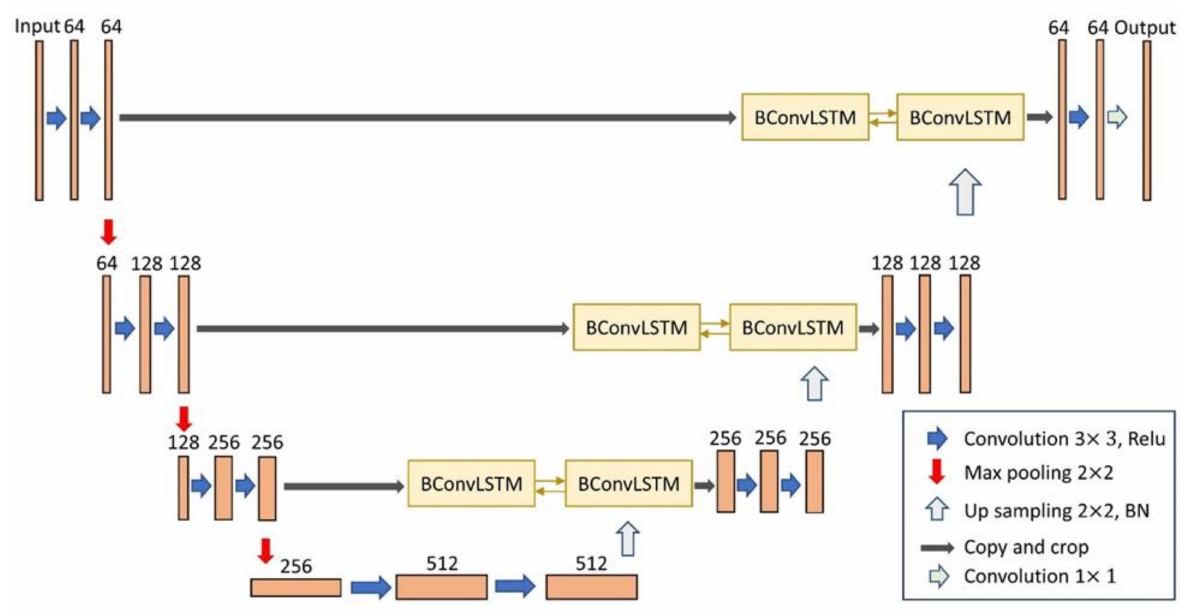
Figure 2. UNet model without any dense connections and with BConvLSTM in the skip connections.